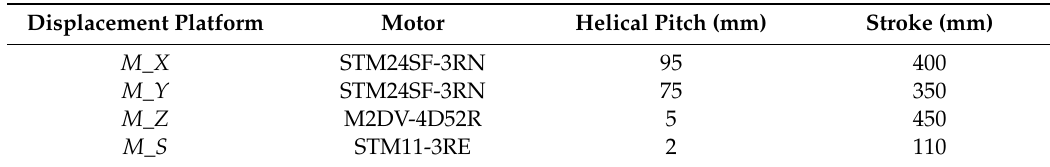
Table 1. The parameters of each axis on displacement platform.